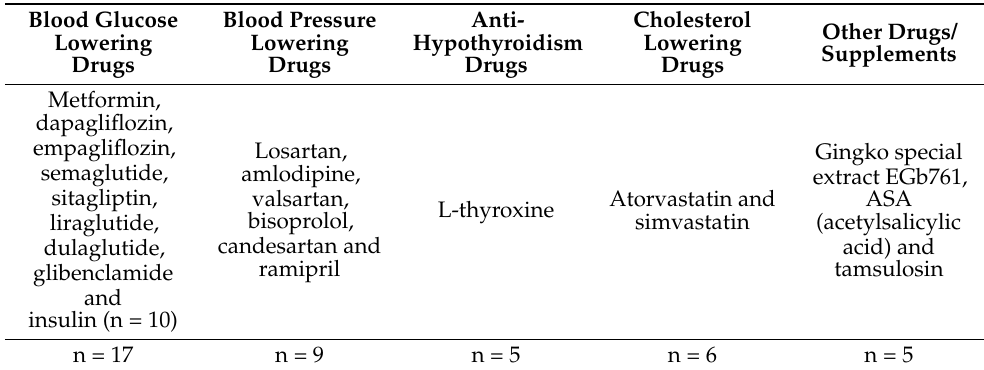
Table 2. Participants’ medication.